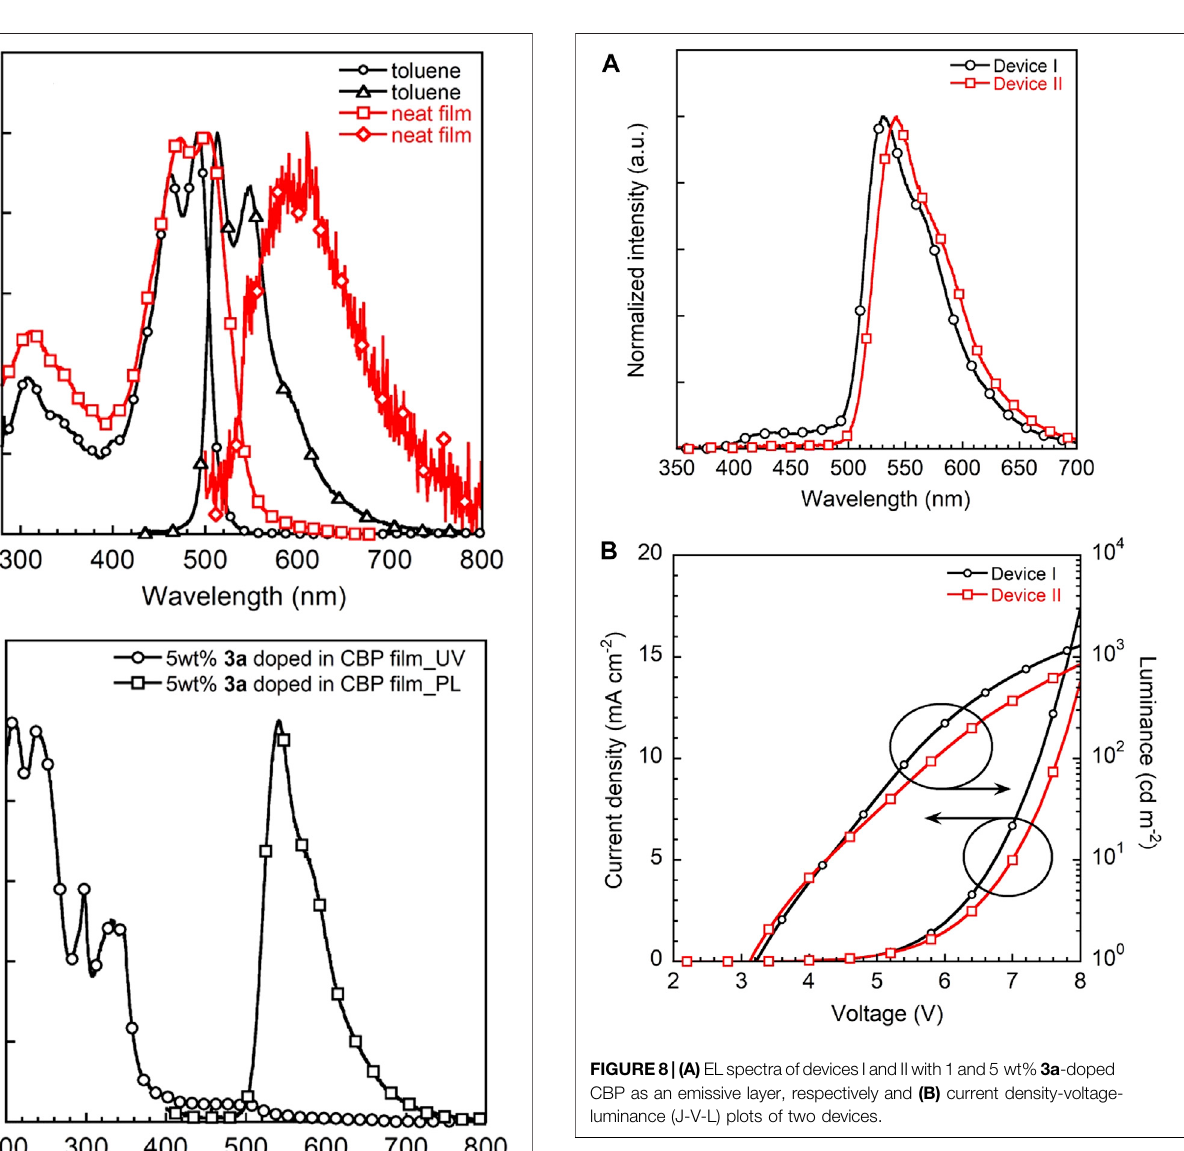
Frontiers in Chemistry |